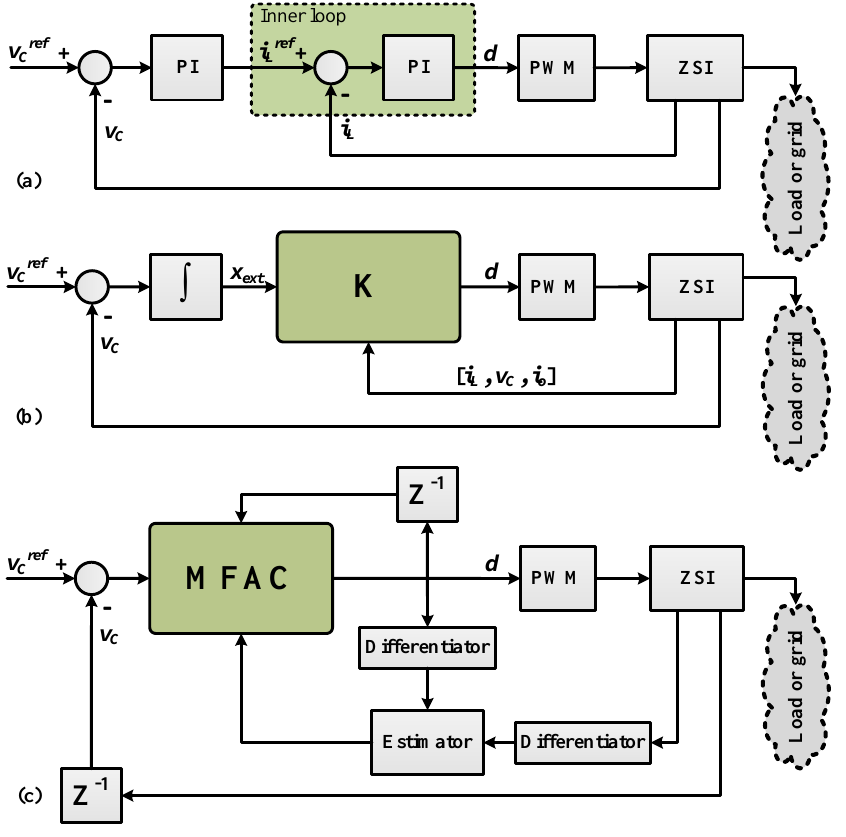
Figure 3. Double-loop control of a ZSI using ( a ) PI control, ( b ) state-feedback, and ( c ) proposed